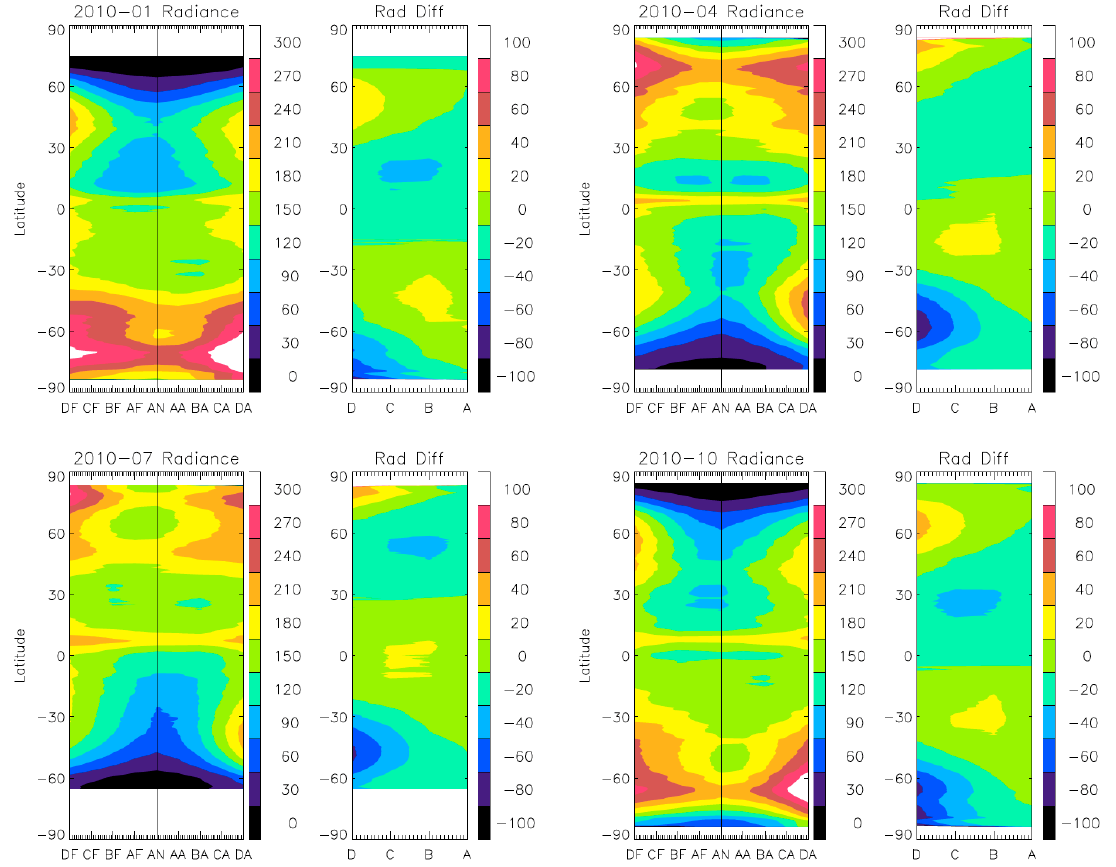
Figure 7. MISR blue-band monthly radiance and radiance anisotropy for January, April, July, and October 2010. Radiances have units W/m 2 /nm/sr. The radiance anisotropy is calculated as the difference between each symmetric pair (e.g., DF-DA, CF-CA). A similar climatology is seen in other MISR spectral band radiances.